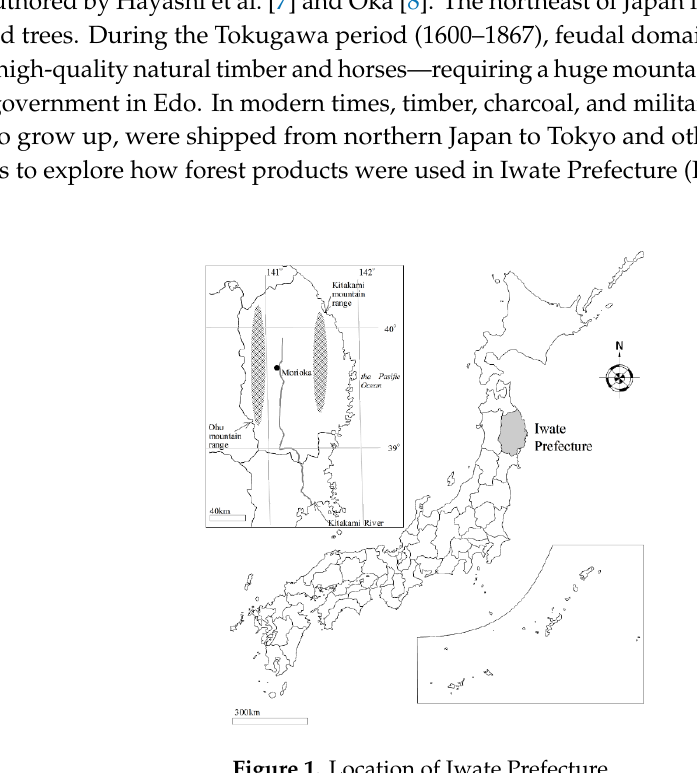
Figure 1. Location of Iwate Prefecture.